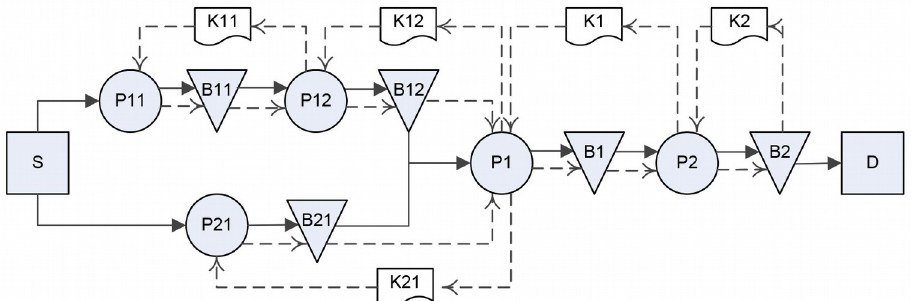
Figure 3. Conceptual mechanism of Kanban (A1) system